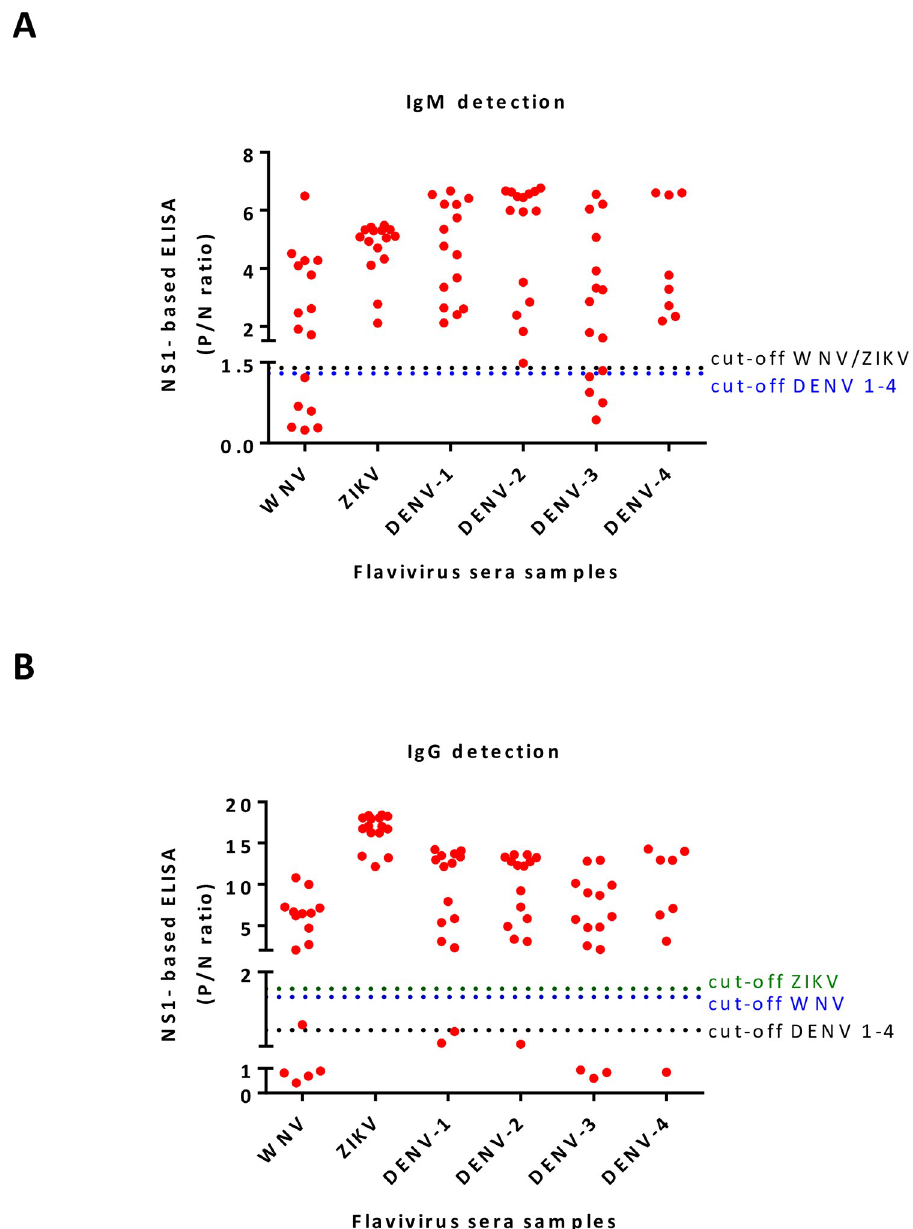
Fig 4. Detection of IgM/IgG antibodies from WNV, ZIKV and DENV 1–4 infected individuals. A and B) Detection of IgM (A) IgG (B) antibodies by rNS1-based ELISA. Each group of RT-PCR confirmed patients were screened for the presence of IgM/IgG antibodies by rNS1-based ELISA tests using specific purified rNS1 antigens. Optimal cut-off values of P/N ratios were calculated based on ROC curve analysis. Each cut-off was selected based on the P/N ratio value, which gave 100% sensitivity and specificity. � each ELISA result includes the average of two biological replicates.